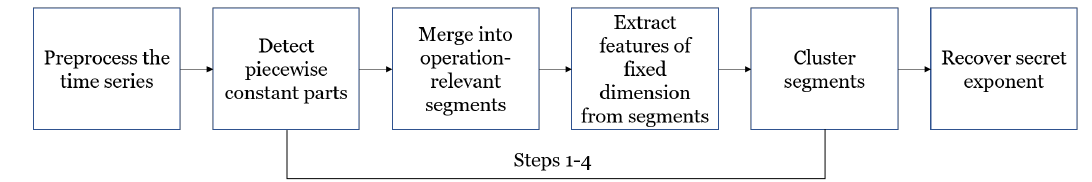
Figure 1. Whole process for our